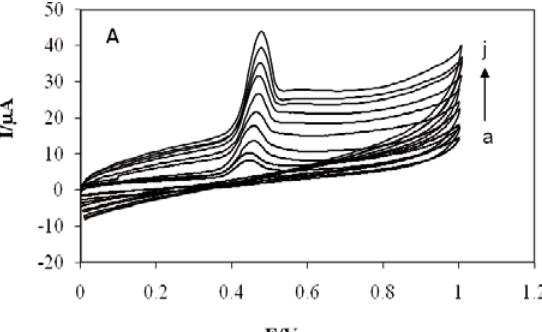
Figure 5. (A) Cyclic voltammorams of ZMCCE in phosphate buffer (pH 7) containing 9.9×10 -6 M Piroxicam at scan rates 10-100 mV s -1